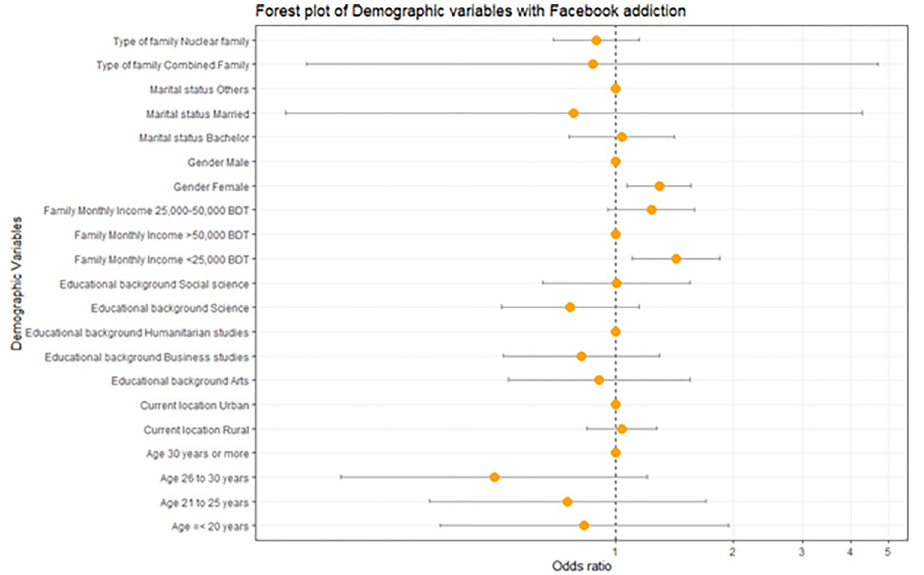
Fig 1. Forest plot of demographic variables with Facebook